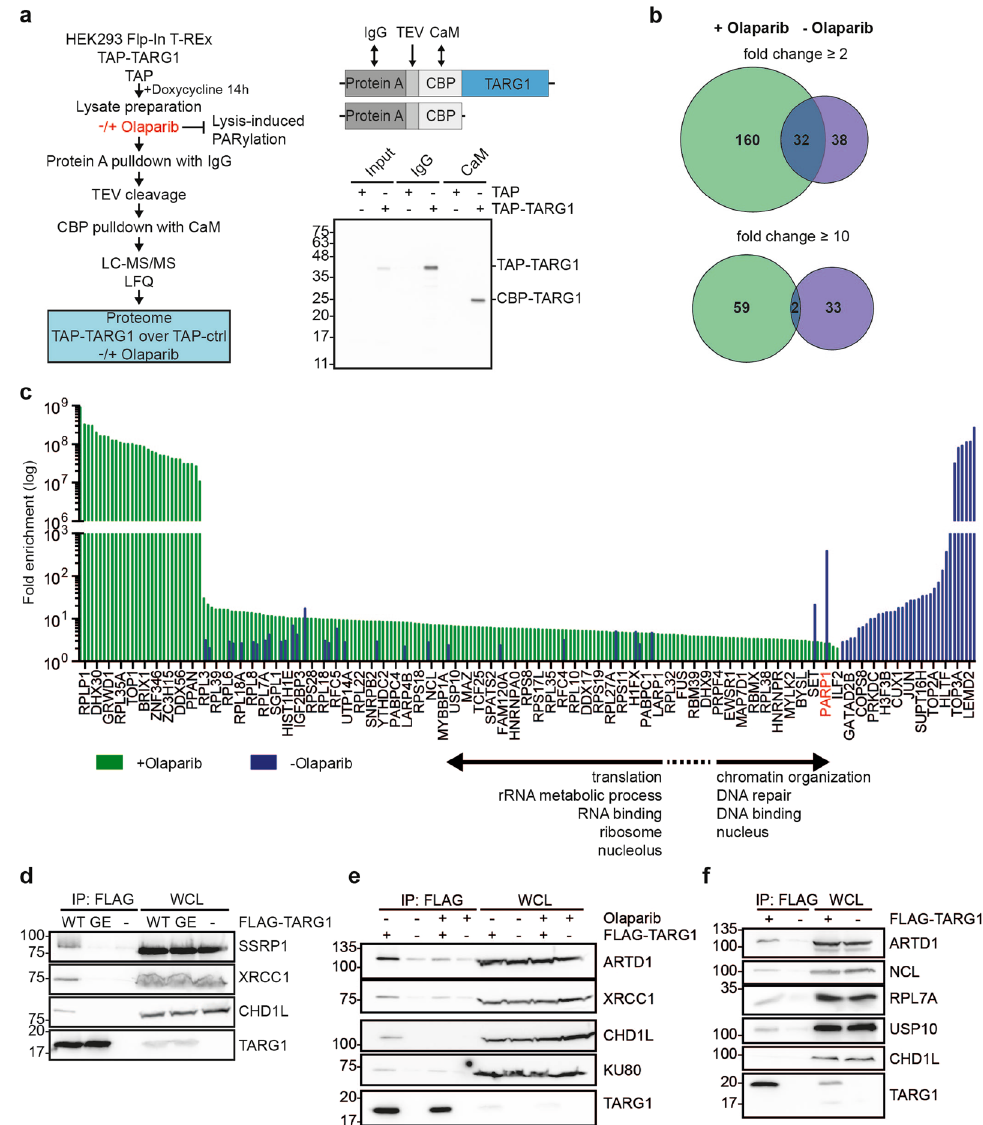
Figure 1. Tandem affinity purification of TARG1-containing protein complexes suggests functions of TARG1 in RNA biology. ( a ) Left panel: HEK293 Flp-In ™ T-REx ™ cells expressing TAP-TARG1 or the TAP-tag alone after doxycycline induction were lysed in the presence or absence of olaparib to inhibit ARTD1/2 activation during cell lysis. TAP-tag containing complexes were purified in two sequential affinity purification steps. Co-purified proteins were analyzed by LC-MS/MS and relative enrichment of TAP-TARG1 over TAP-tag control was determined by label- free quantitation (LFQ). Upper right panel: Domain structure of TAP-TARG1 and TAP constructs. Lower right panel: Fractions of the input lysate, the IgG and the CaM pulldown were analyzed for TARG1 by Western blot using mAb 3A5 (for characterization of TARG1 antibodies see Supplementary Fig. S3). ( b ) Venn diagrams depicting the overlap between proteins associated with TARG1 in proteomics screens conducted in the absence (three biological replicates, p ≤ 0.01) or presence (two biological replicates, p ≤ 0.01) of olaparib in the lysis buffer with a fold enrichment of ≥ 2 (upper diagram) or ≥ 10 (lower diagram) over TAP control. ( c ) Fold enrichment of all proteins identified as TARG1 interacting proteins (p ≤ 0.01, ≥ 2-fold enrichment over TAP control) both in the absence and presence of olaparib. Only a fraction of grouped bars is specified with the corresponding protein names on the x-axis for clarity reasons. For details on the identified proteins see Supplementary Table S1, Supplementary Datasets S1 and S2. ( d ) HEK293 cells were transfected with plasmids encoding for FLAG-TARG1 wildtype (WT) or ADPr binding-deficient FLAG- TARG1-G123E (GE). Presence of SSRP1, XRCC1 and CHD1L in FLAG immunoprecipitates (IP) and whole cell lysates (WCL) was analyzed by Western blotting. ( e ) HEK293 cells transiently expressing FLAG-TARG1 were lysed in TAP lysis buffer ± 10 µ M olaparib. Presence of ARTD1, XRCC1, CHD1L, KU80 and TARG1 after IP of FLAG- TARG1 was analyzed by Western blotting. ( f ) HEK293T cells transiently expressing FLAG-TARG1 were lysed in the presence of 10 µ M olaparib. Presence of ARTD1, NCL, RPL7A and USP10 after IP against FLAG-TARG1 was analyzed by Western blotting. CHD1L was detected to control for inhibition of lysis-induced PARylation. ( d–f ) Full- length blots are presented in Supplementary Fig.